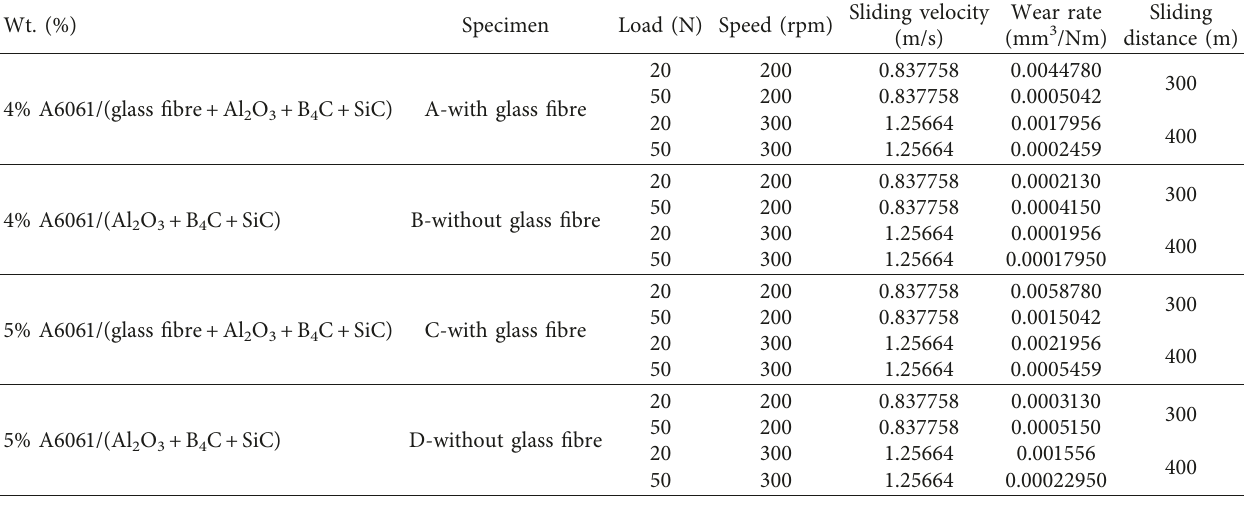
Table 6: Wear rates of the proposed hybrid MMC specimens.